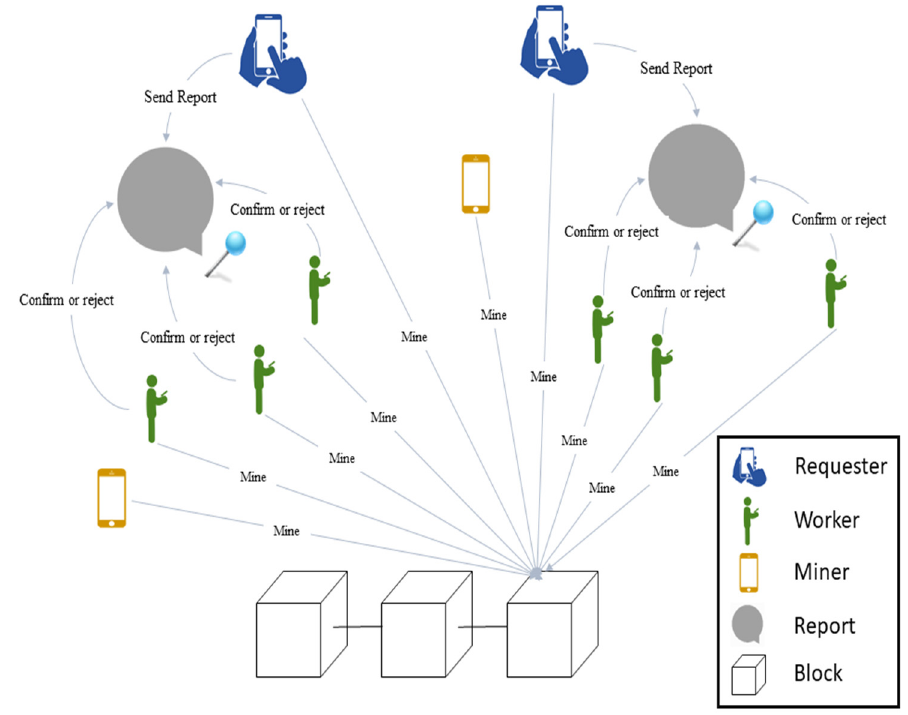
Figure 1. Proposed system architecture.